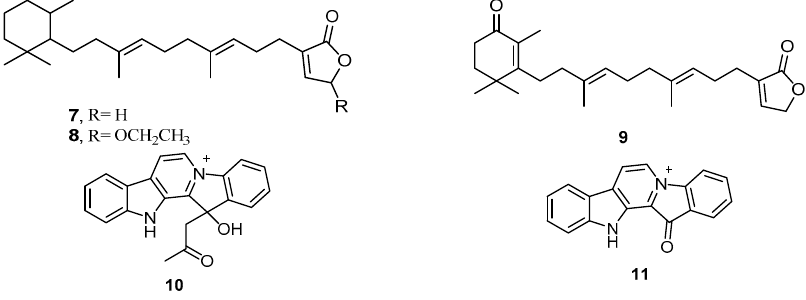
Figure 4. Chemical structures of compound 7 , compound 8 , isodehydroluffariellolide ( 9 ), homofascaplysin A ( 10 ) and fascaplysin ( 11 ).